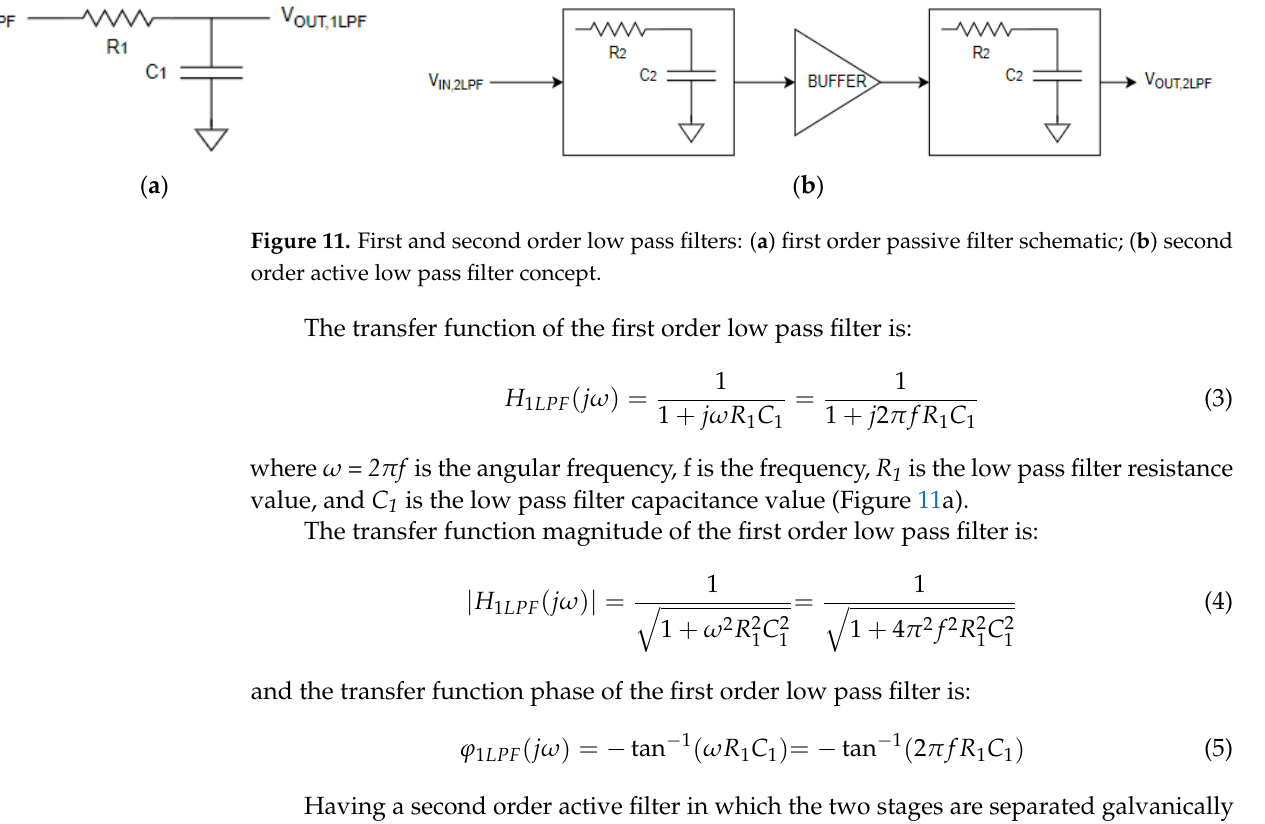
IN and frequency, which is demonstrated below. V IN is DC shifted and the